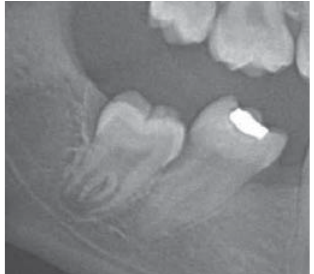
FIGURE 5. Pathology associated with impacted mandibular third molars: radiograph of root resorption of second mandibu- lar molar as result of semi-impacted third